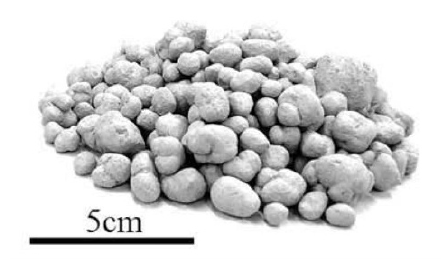
Figure 6. Pelletized lightweight aggregate product. Reprinted from Waste Management, Vol. 29, Gunning et al. [105], 2722- 2728, Copyright 2009, with permission from